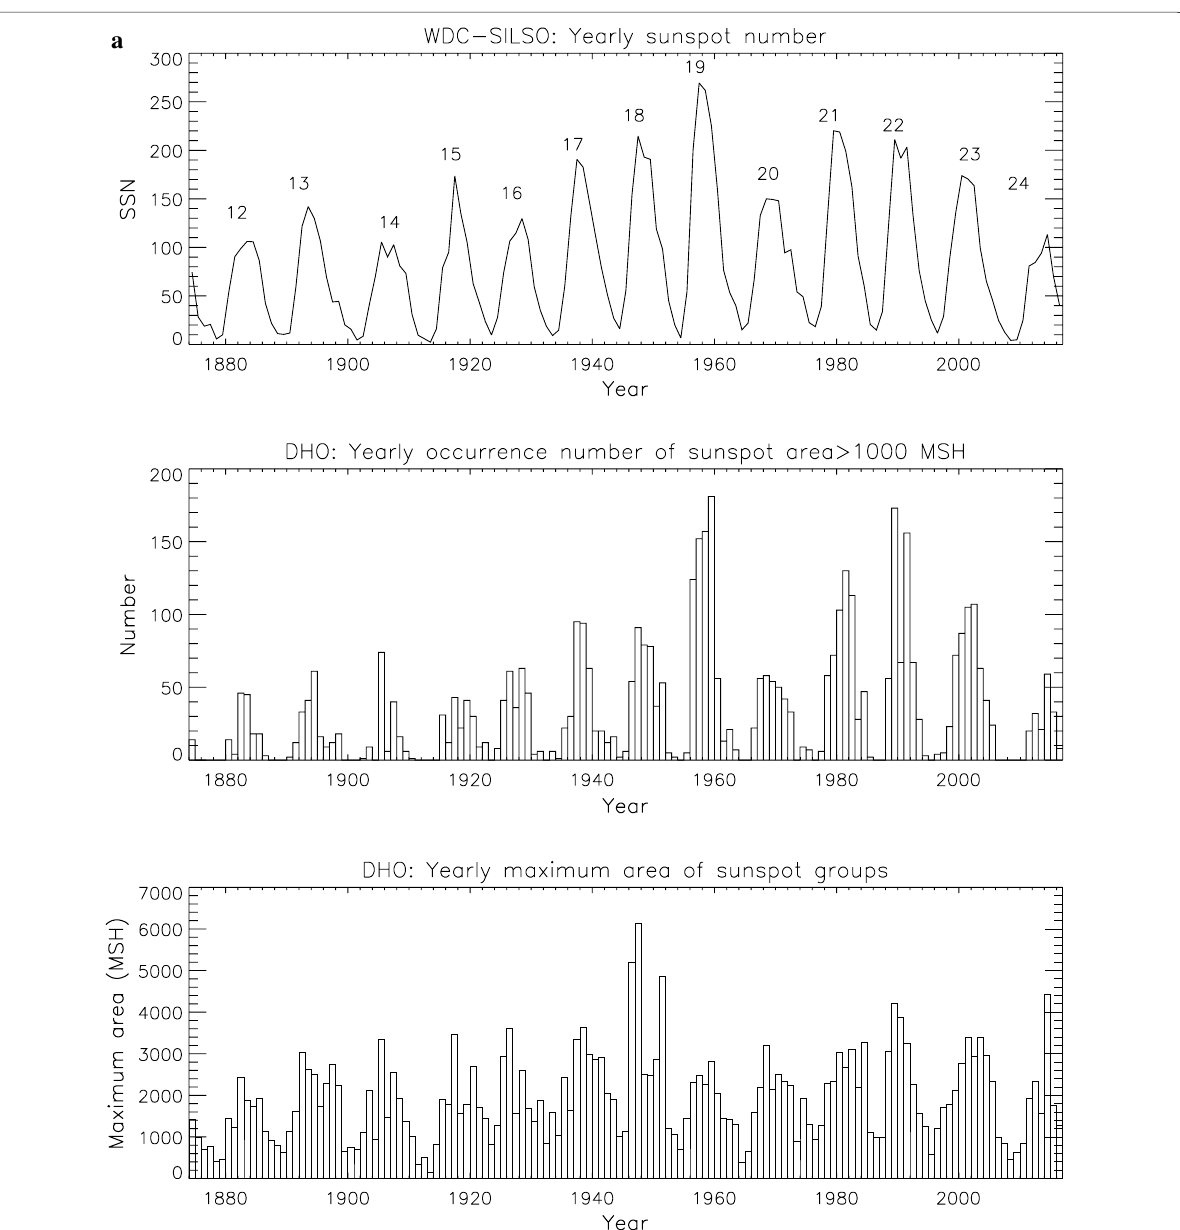
Fig. 2 a Yearly sunspot number, yearly number of sunspot areas of more than 1000 MSH, and yearly maximum area of sunspot groups in the DHO catalogue. b Yearly sunspot number, yearly number of sunspot area of more than 1000 MSH, and yearly maximum area of sunspot groups in